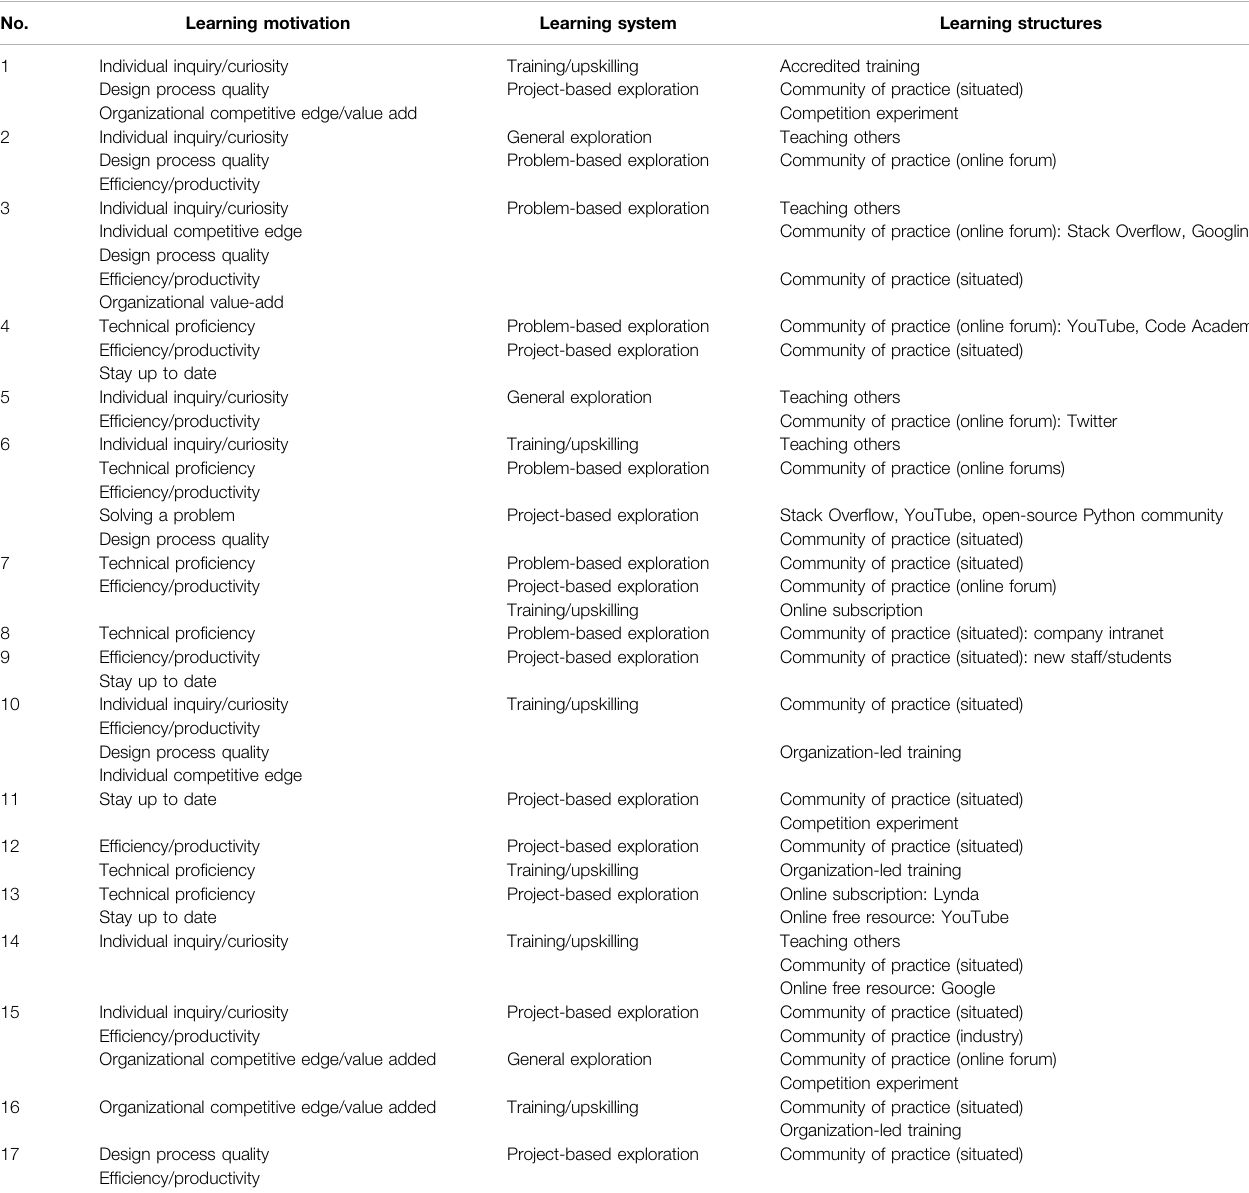
TABLE 3 | Interviewee learning motivations, systems and